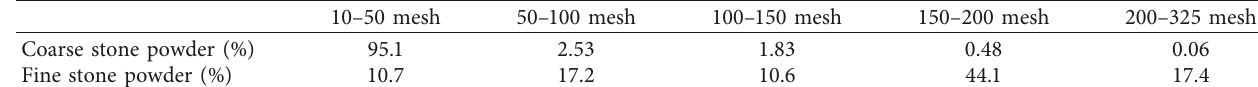
Table 3: Screening of stone powder particles.